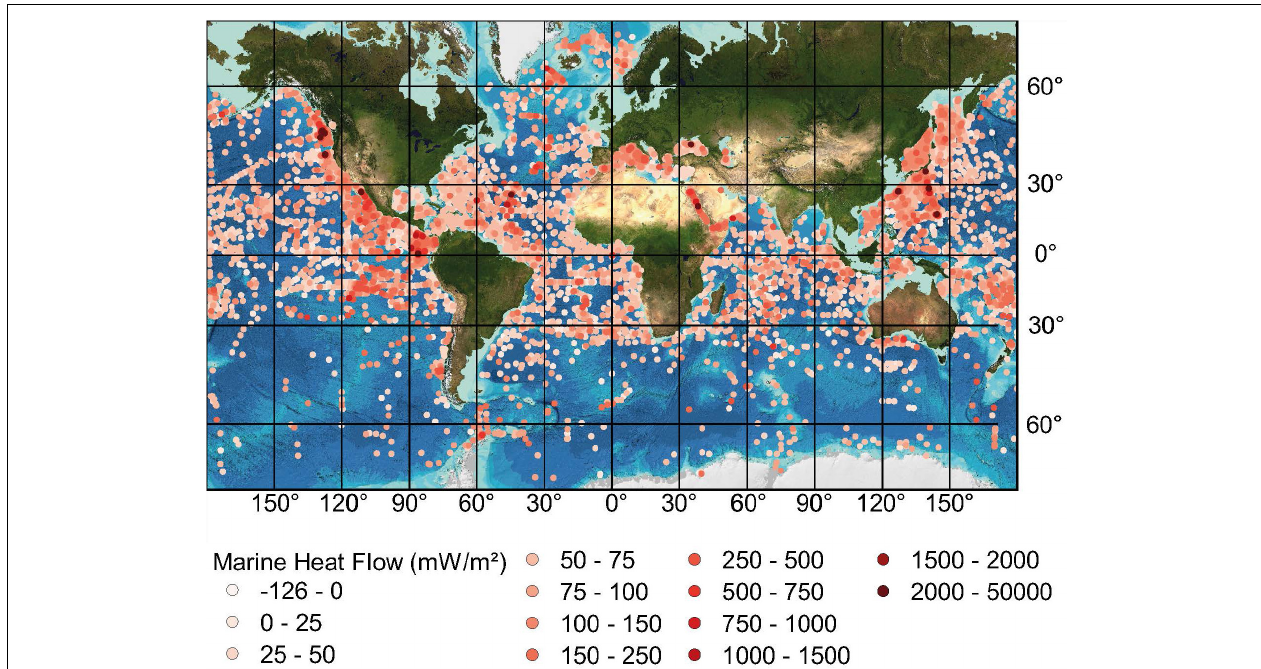
FIGURE 7 | Global distribution of heat flow measurements at water depths > 500 m (Global Heat Flow Compilation Group, 2013; https://doi.pangaea.de/10.1594/PANGAEA.810104). Highest values are found at active spreading centers. To date, no systemic deviations along/across MTFFZs have been observed (background map is reproduced from the GEBCO world map 2014, www.gebco.net).